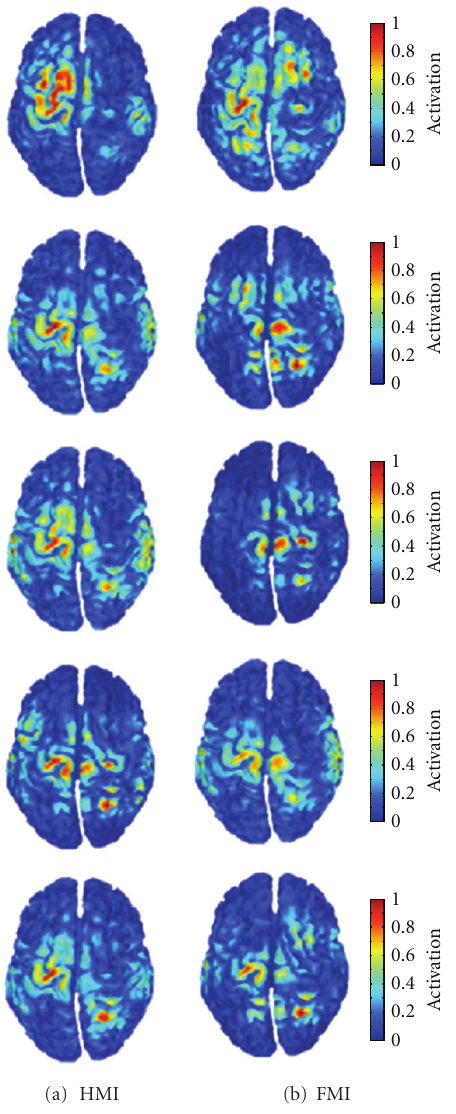
Figure 1: Cortical source activation maps produced by eCon- nectome after solving the inverse problem using Current Cortical Density. Poststimuli instances for 5 subjects during (a) Hand Motor Imagery (HMI) and (b) Foot Motor Imagery (FMI). Di ff erent activation patterns can be observed for di ff erent subjects, but in all of them, the hand and foot imagery are discriminated.